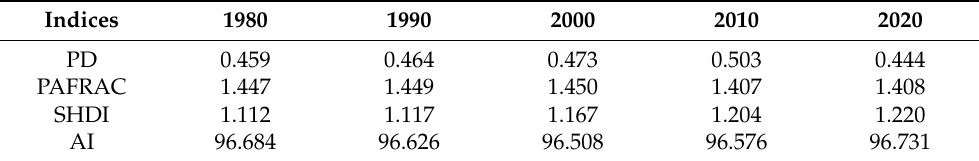
Table 6. Landscape indices at the landscape level.